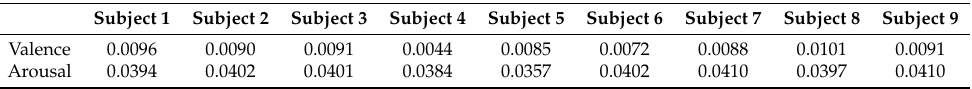
Figure 5. Estimated (orange) and ground truth (blue) values of valence and arousal for an indicative speaker of the testing set of RECOLA. ( a ) Valence. ( b ) Arousal. Table 6. Best MSE values of valence and arousal using R 3 { 98,128,2 } for every speaker of the validation